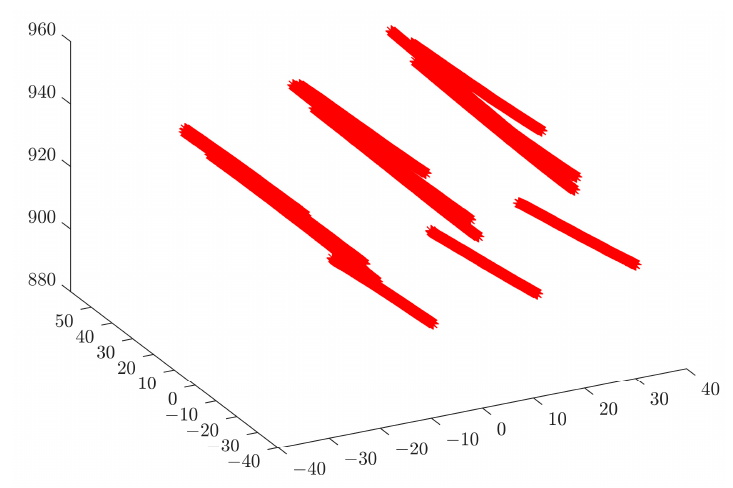
Figure 7. Three sets of 3-D points.